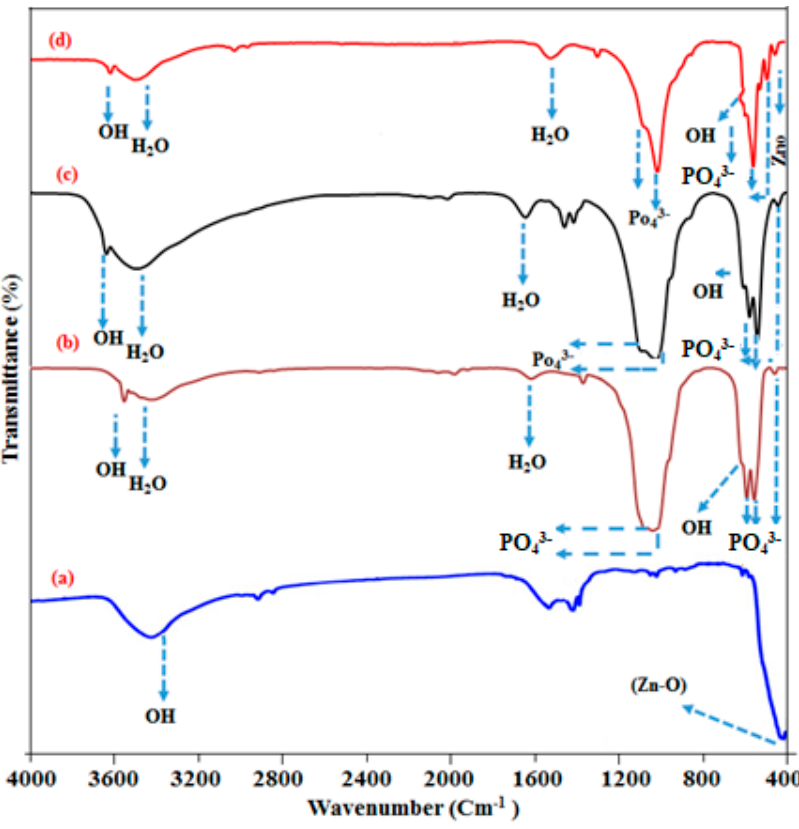
Figure 4. FTIR spectra of ( a ) ZnO, ( b ) HAp, ( c ) Mn-HAp, and ( d ) Mn-HAp/ZnO bilayer coating on 316L SS.